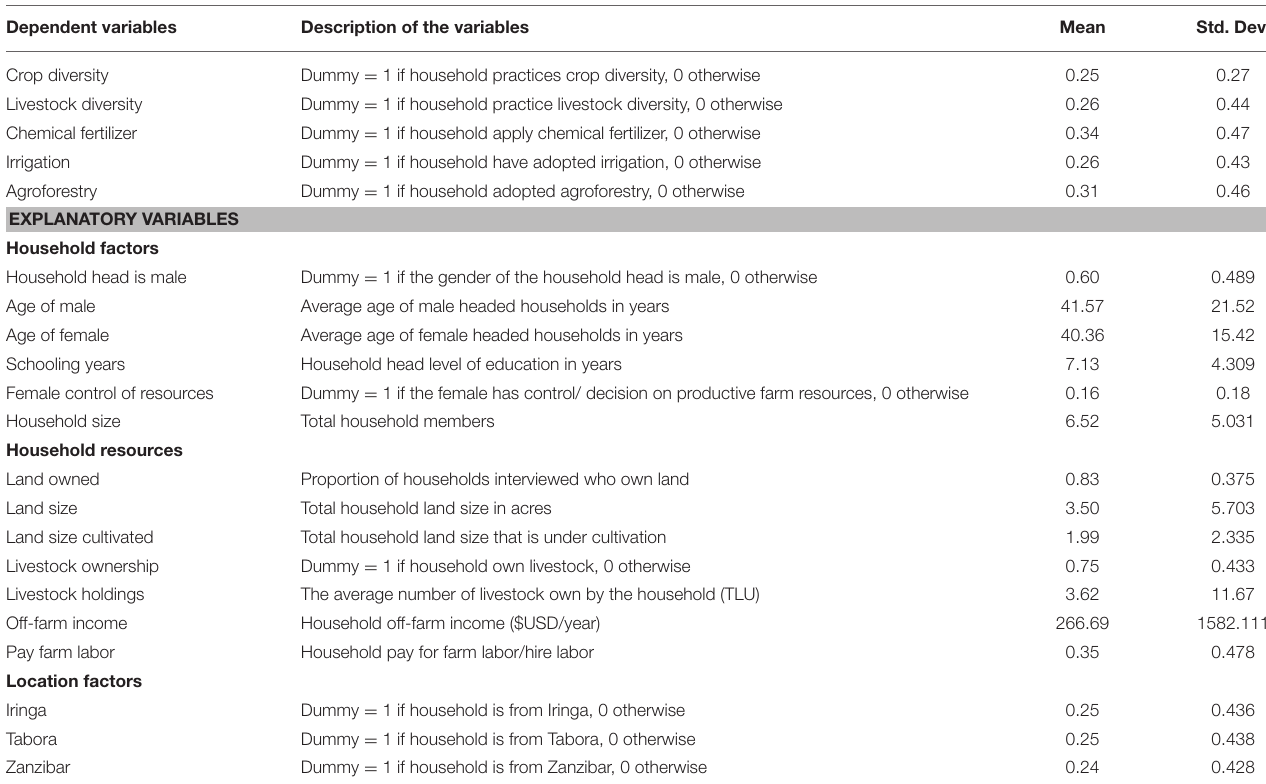
TABLE 2 | Description of variables used in the multivariate probit model. Dependent